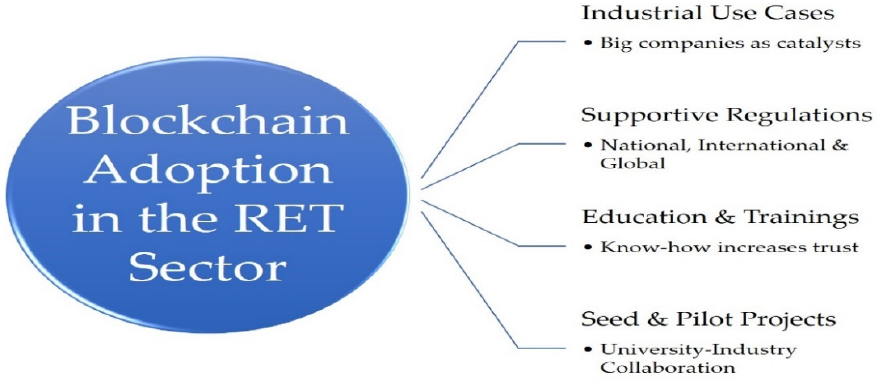
Figure 3. Roadmap for Blockchain Adoption.